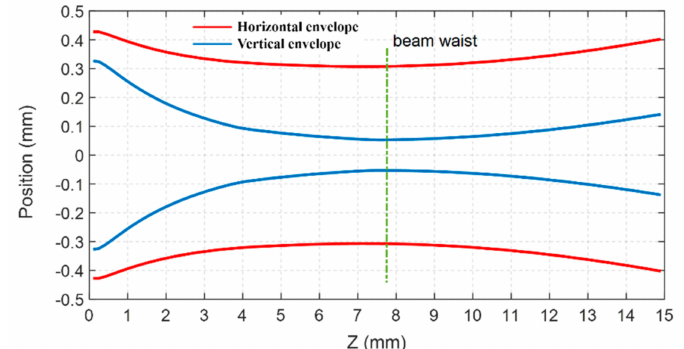
Figure 3. The envelopes of the electrostatic trajectories of the sheet